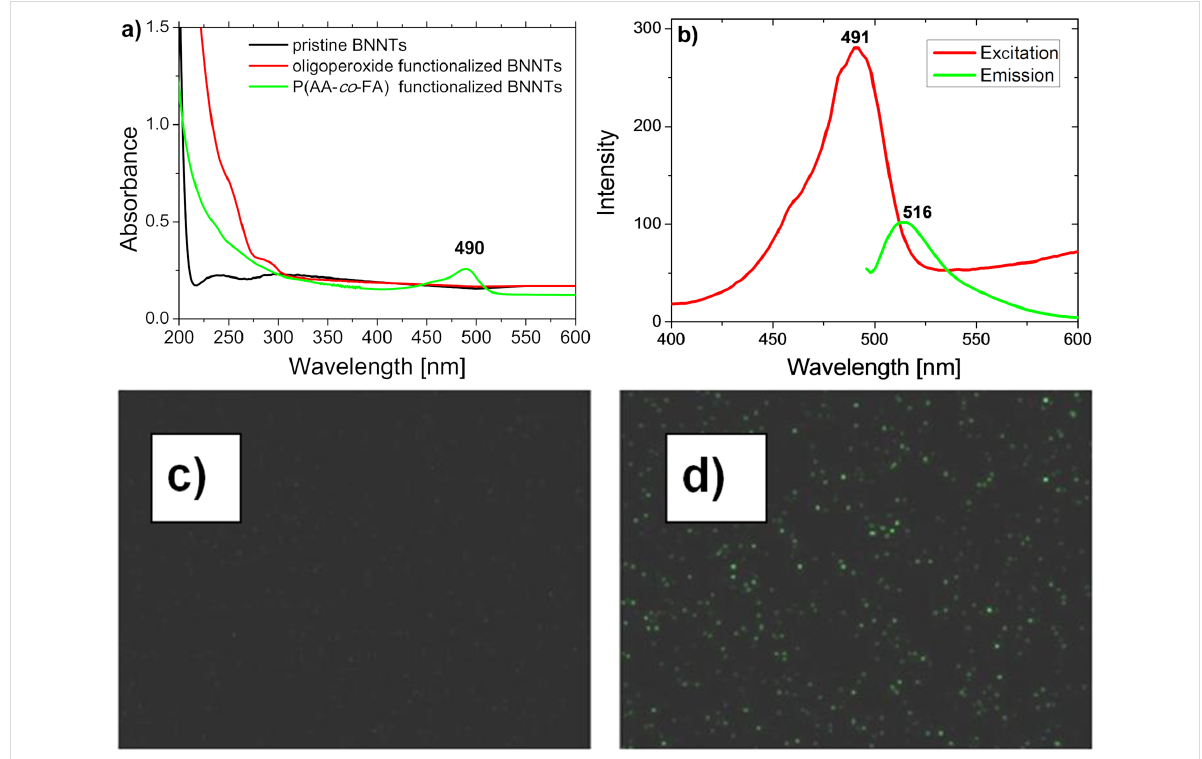
Figure 4: UV–vis spectra of BNNTs, oligoperoxide-functionalized BNNTs and P(AA- co -FA)-functionalized BNNTs (a) and fluorescence of P(AA- co - FA)-functionalized BNNTs (b). Laser scanning confocal microscope images of pure BNNT (c) and P(AA- co -FA)-functionalized BNNTs (d).